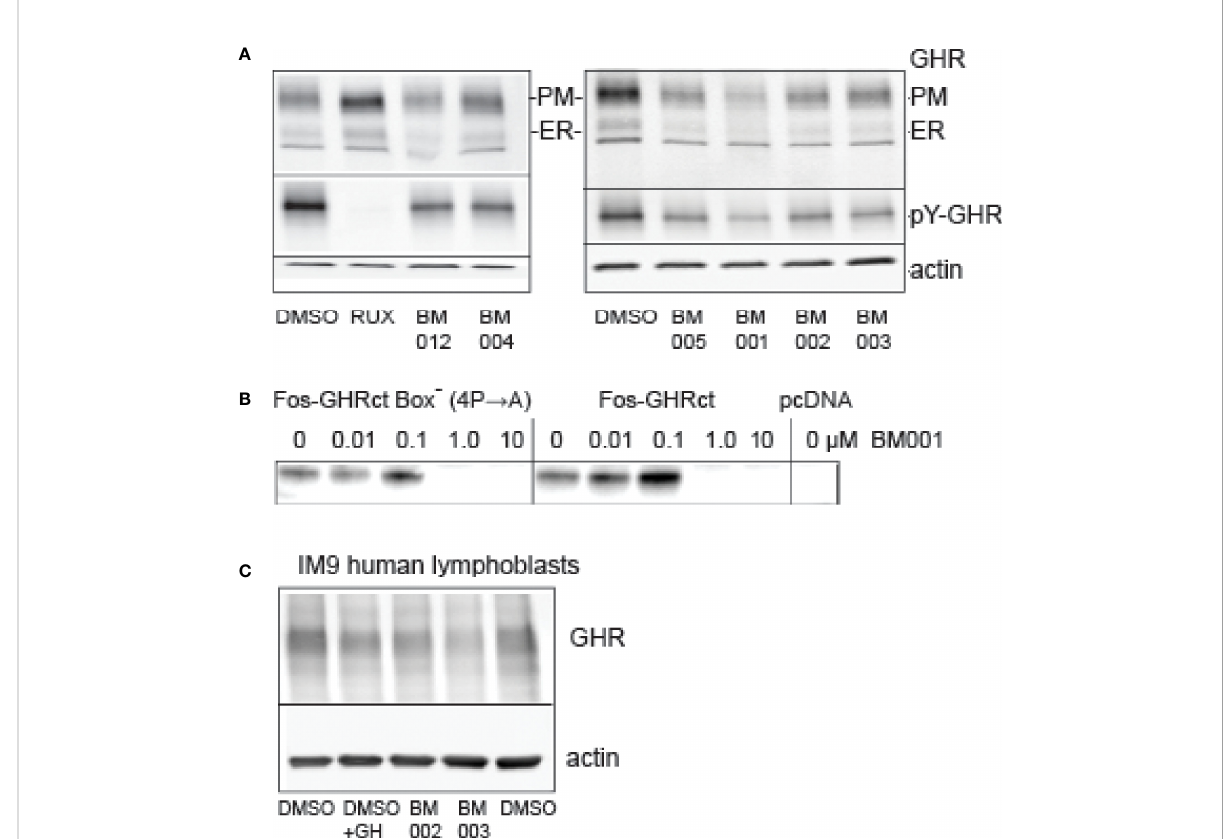
FIGURE 7 Effect of drugs on protein synthesis. (A) : Effect of compounds on GHR. Hek293T cells, transfected with GHR, were treated overnight with 10 µM drugs as indicated (RUX, Ruxolitinib). The amounts of GHR both at the plasma membrane (PM) and in the ER (ER) were decreased in the drug- treated cells. BM001 had the strongest effect. The cells were treated for GH for 10 min before lysis to be able to monitor the pY signals, after GHR isolation by immunoprecipitation (middle panels). The effect of the drugs on the pY signals re fl ected those of the GHR levels (only PM species were visible). In the presence of Ruxolitinib, the protein levels were unchanged, while the pY label (middle panel) was absent. The lower panel (actin) shows that the amounts of cells were identical across the experiment. This experiment represents the results of 6 independent repeats. (B) : BM001 concentration effects on the synthesis of fos-GHRct in a HeLa cell cell-free system. Synthesis was inhibited irrespective of the presence of a functional box-1 sequence (IC50 0.1-1.0 µM). In the right panel the 4 proline residues in box-1 were replaced by alanine residues. Empty vector (pcDNA) was used as control. The blots were detected with anti-GHR(B). The in vitro translation was performed 5 times that all show a clear inhibitory effect of BM001 on the GHR signal. (C) : Effect of selected drugs on GHR levels in human lymphoblasts. IM ‐ 9 human B lymphoblasts express endogenous GHR. Lymphoblasts were incubated with the drugs for 4 hrs or with GH for 1 hr. GHRs were isolated by immunoprecipitation. Drugs BM002 and BM003 reduce the levels of GHR to ~60% in 4 h. This experiment is representative of 6 independent